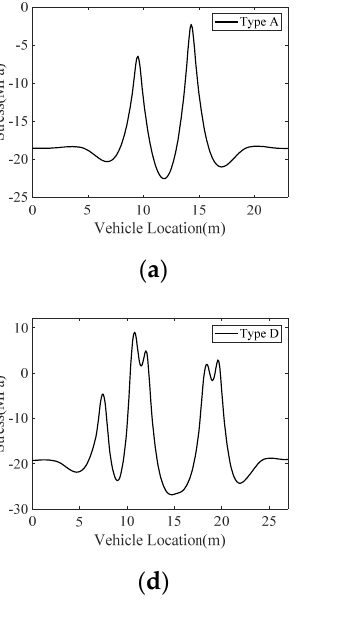
Figure 8. Time histories of vehicle-induced nominal stress at the critical location for different vehicle types. ( a ) Type A. ( b ) Type B. ( c ) Type C. ( d ) Type D. ( e ) Type E. ( g ) Type G.